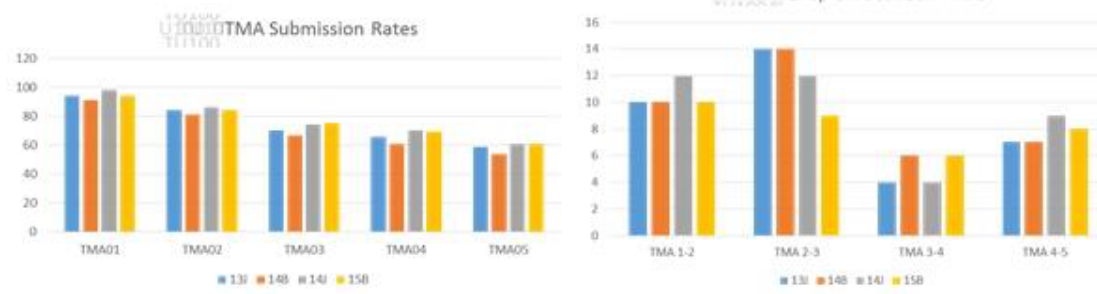
Figure 1. Assessment submission rates over time.